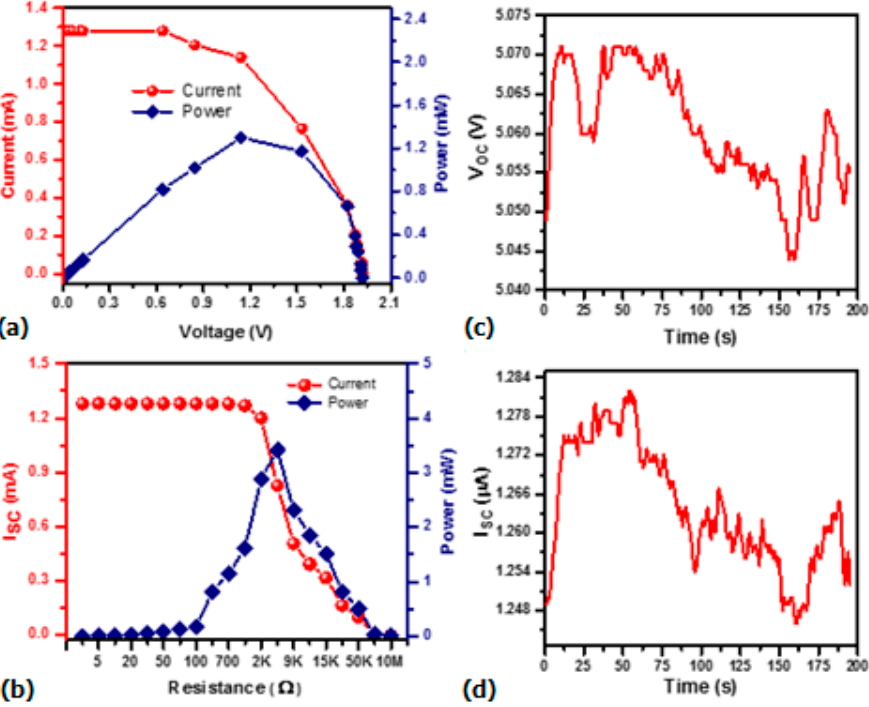
Figure 7. Combined output parameters of the TSHG: ( a ) combined open circuit voltage ( b ) I-V characteristics curve of a single PV film ( c ) combined short-circuit current ( d ) power output at different loading conditions.